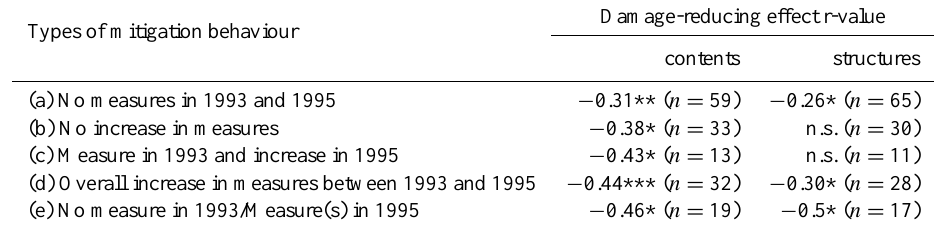
Table 4. Damage-reducing effect of flood mitigation measures for respondents with different flood mitigation